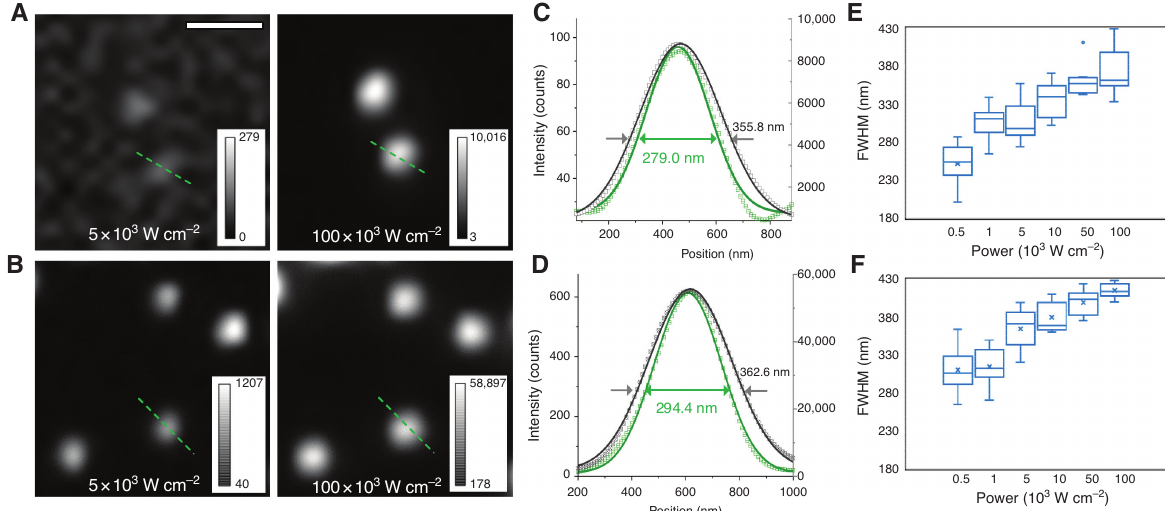
Figure 3: Laser scanning upconverting nonlinear image and saturated image of single 4% Tm 3 + , 20% Yb 3 + core UCNPs and single 8% Tm 3 + , 60% Yb 3 + core-shell UCNPs. (A) 4% Tm 3 + , 20% Yb 3 + core single UCNPs under nonlinear excitation (5 × 10 3 W/cm 2 ) and saturated excitation (100 × 10 3 W/cm 2 ), respectively. (B) 8% Tm 3 + , 60% Yb 3 + core-shell single UCNPs under nonlinear excitation (5 × 10 3 W/cm 2 ) and saturated excitation (100 × 10 3 W/cm 2 ), respectively. Scale bar, 1 μ m. The cross-section on the green dashed line in (A and B) are shown in (C and D). The fitted curves of nonlinear excitation (green) have a smaller FWHM than the saturated excitation ones (gray) due to different order of nonlinearity. (E and F) FWHM under different power density excitation of 4% Tm 3 + , 20% Yb 3 + core UCNPs and 8% Tm 3 + , 60% Yb 3 + core-shell UCNPs,